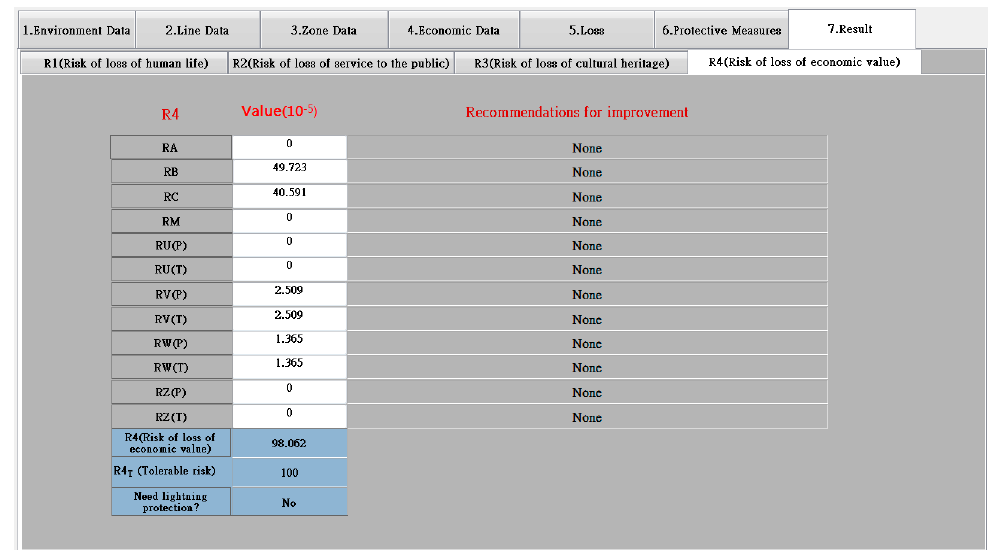
Figure 9. The R4 after using protection measures.